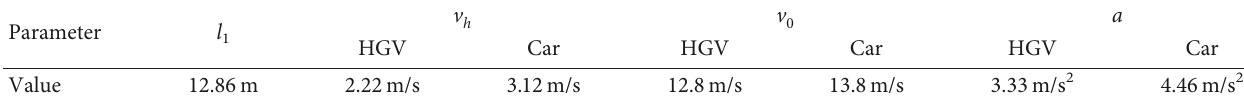
Table 3. Among them, the upper and lower bounds of the desired speed correspond to the maximal and minimal speeds in equation (2).